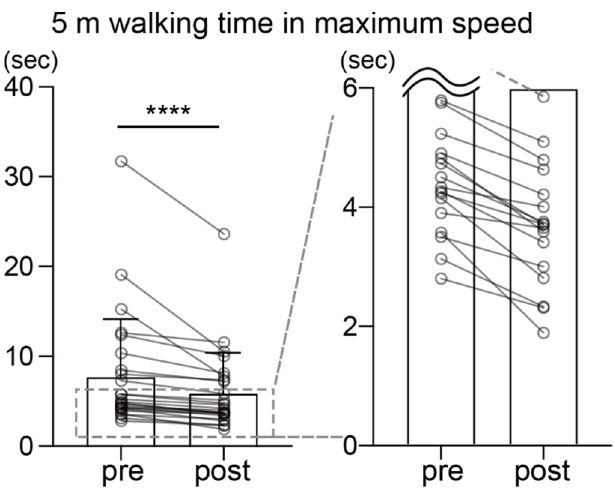
Figure 4. Pre-/post-comparison of 5 m maximum-speed walking time. Each plot shows the data of a subject, and the pre- and post-intervention data are connected by lines. The bar graph shows the mean value. The graph on the right is a magnified view of the area enclosed by the dotted line. **** p < 0.0001, error bar = SD, n =